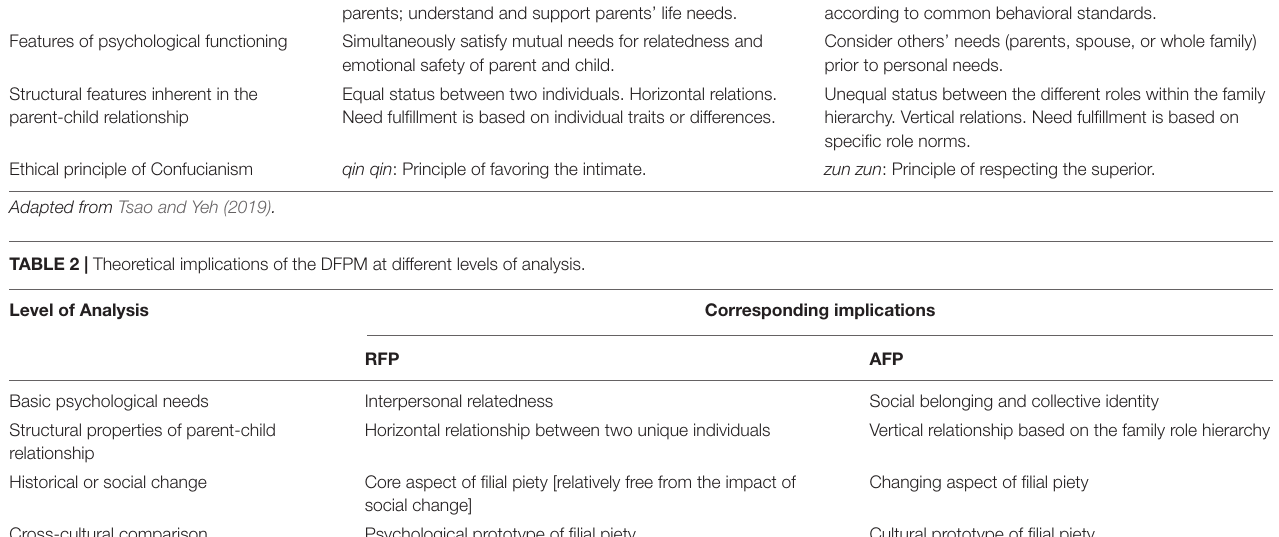
TABLE 1 | The dual filial piety model: Psychological schemas for interaction with parents. Reciprocal filial dimension Authoritarian filial dimension Psychological needs Need for interpersonal relatedness with another individual. Manifestation in developmental stages